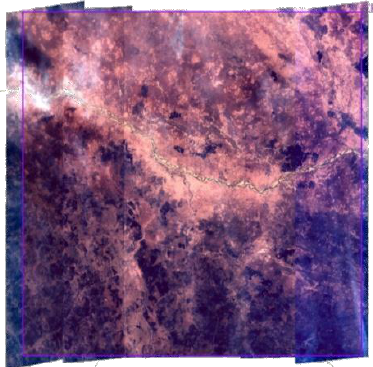
Figure 3 – Single-pass Pléiades collection imaging a 1° x 1° geocell over Chad (purple frame) on Feb 10 th ,